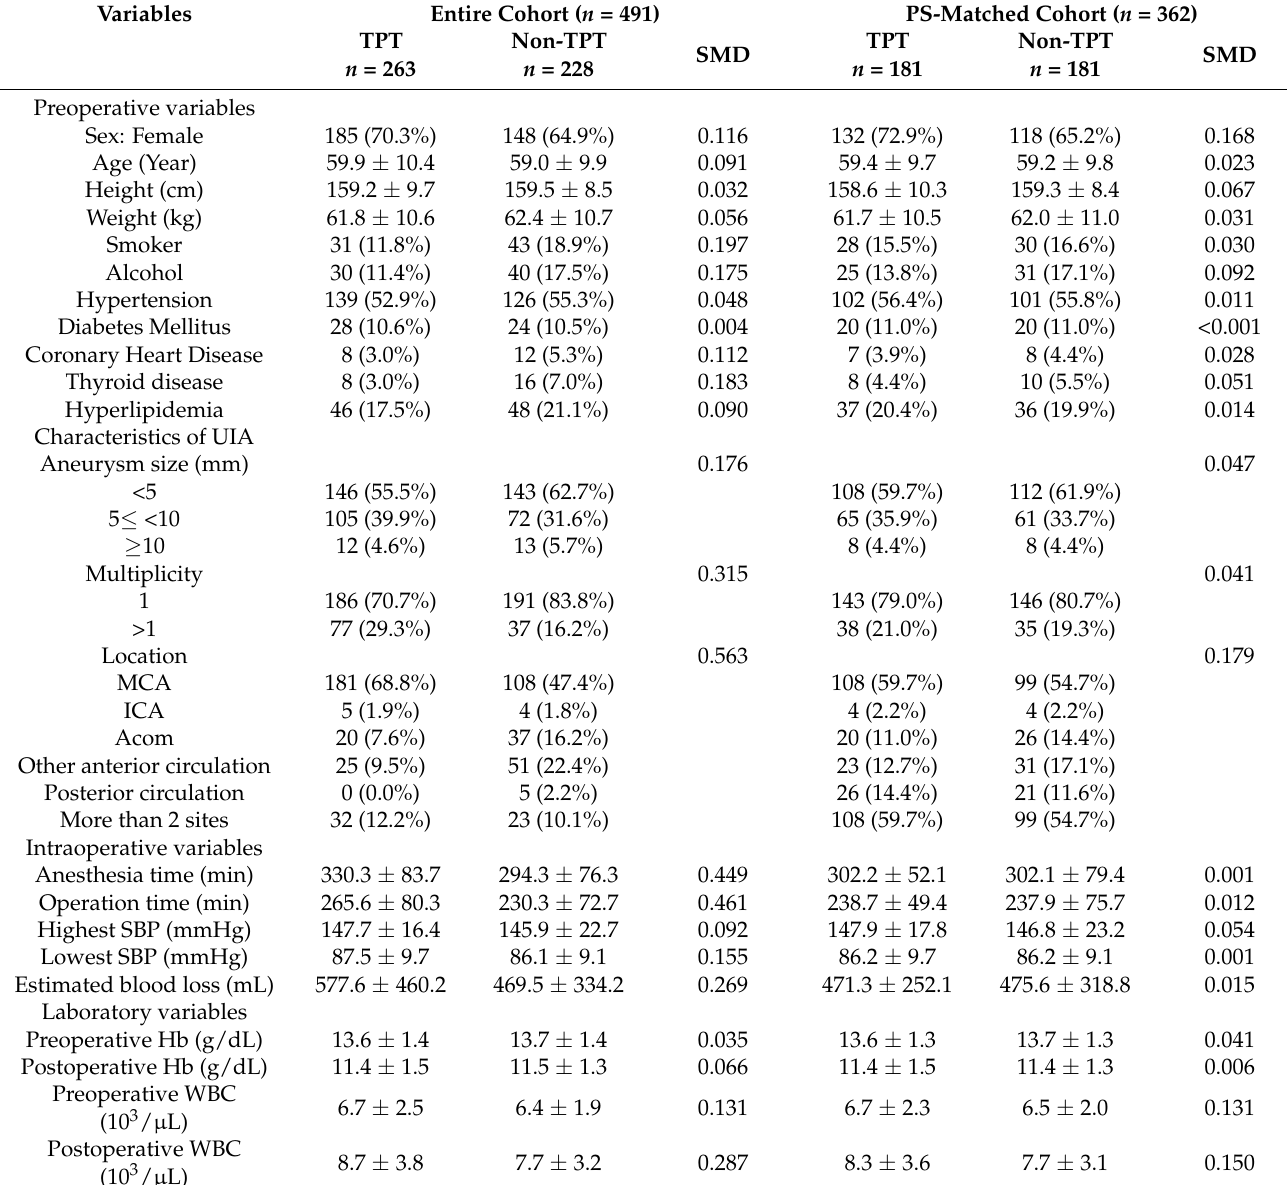
Table 1. Comparisons of demographic variables before and after propensity score